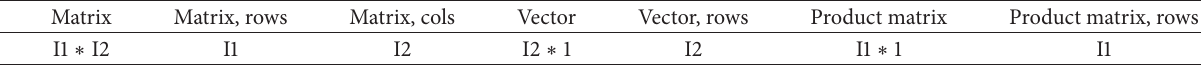
Table 3: Matrix size determination for matrix-vector multiplication.